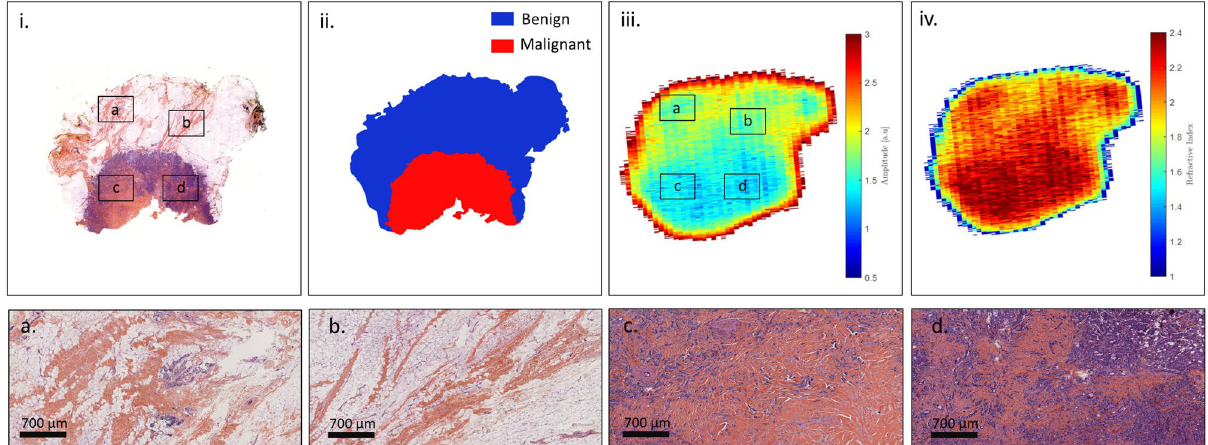
Figure 7. Sample TS#1. (i) Pathology image and correlated view of the respective zones ( a , b , c , d ); (ii) pathology mask; (iii) raw terahertz image at 550-GHz; (iv) refractive index map at